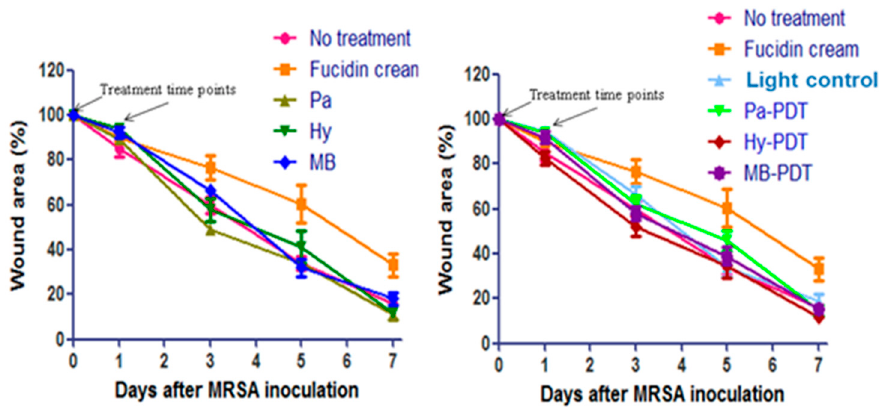
Figure 8. Wound areas of mice in different groups of mice after topical treatment with or without PDT. Data are mean ± SEM ( n = 6–10).